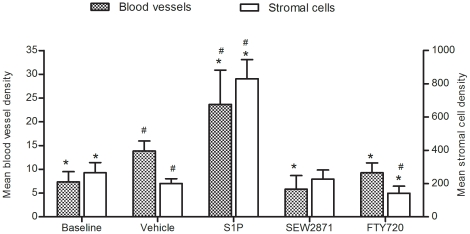
The effect of S1P, SEW2871 and FTY720 on ovarian transplant revascularization and stromal cell population.S1P induces ovarian angiogenesis (Left axis) and increases stromal cell population (Right axis) while its analogs, SEW2871 and FTY720 have the opposite effect, 10 days after grafting of ovarian transplantation. * Significantly different from control. # Significantly different from baseline ovarian tissue.